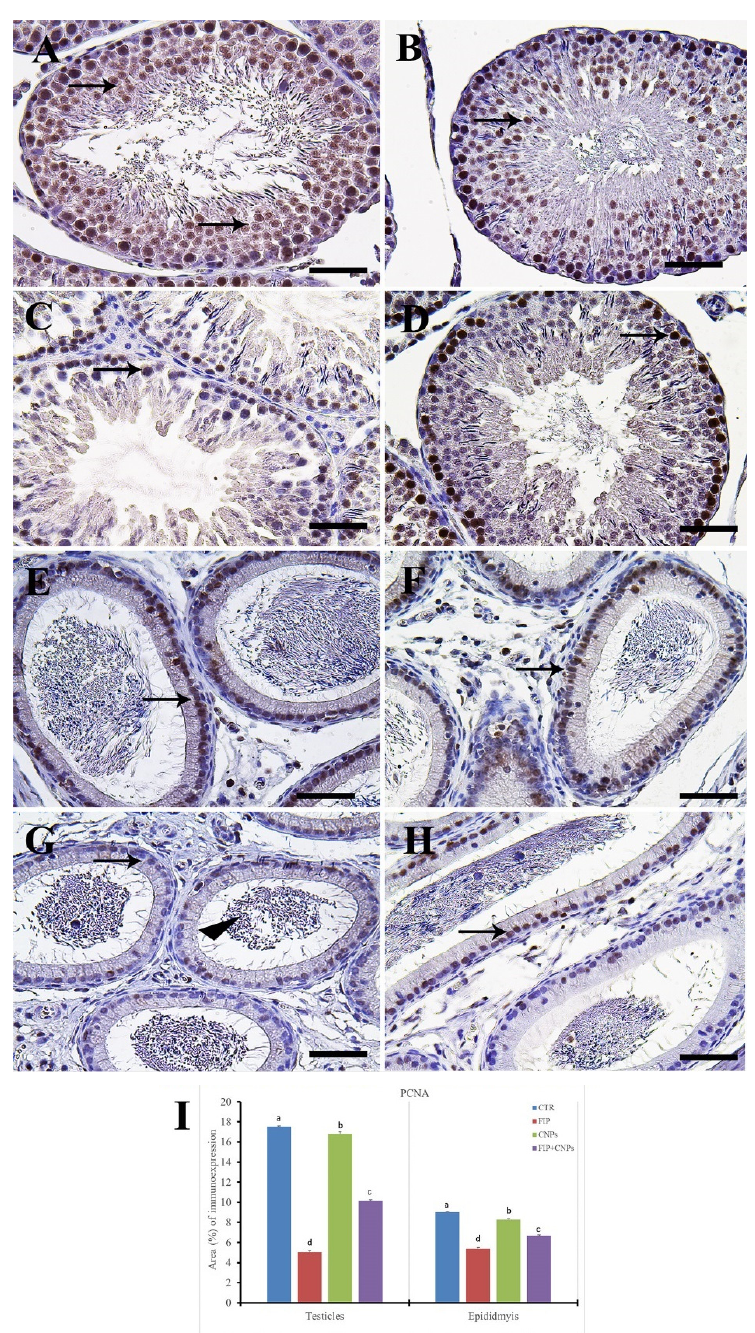
Figure 4. Immunohistochemical staining of rat testis by proliferating cell nuclear antigen (PCNA). ( A ) the control group showed the high PCNA reaction concentrated in the nuclei of all spermatogenic cells (arrows). ( B ) CeNPs group. ( C ) FIP group showed low PCNA reaction (arrows). ( D ) FIP treated with CeNPs. ( E ) Epididymal negative control group showed high PCNA reaction (arrows). ( F ) CeNPs group. ( G ) FIP group with weak PCNA reaction in the epididymal epithelium nuclei (arrow). ( H ) FIP treated with CeNPs. ( I ) Semi-quantification of PCNA in the testicular and epididymal tissues in different groups. Scale bar = 50 µm . Data expressed as mean ± SE, analyzed using one-way ANOVA at p ≤ 0.05.